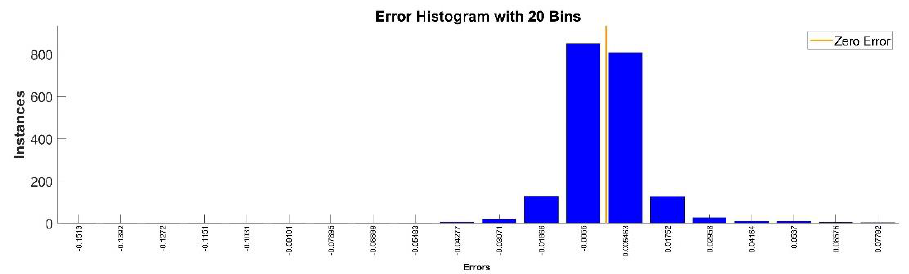
Figure 21. Relative errors between the target values and the predicted values for 𝑞 4 .